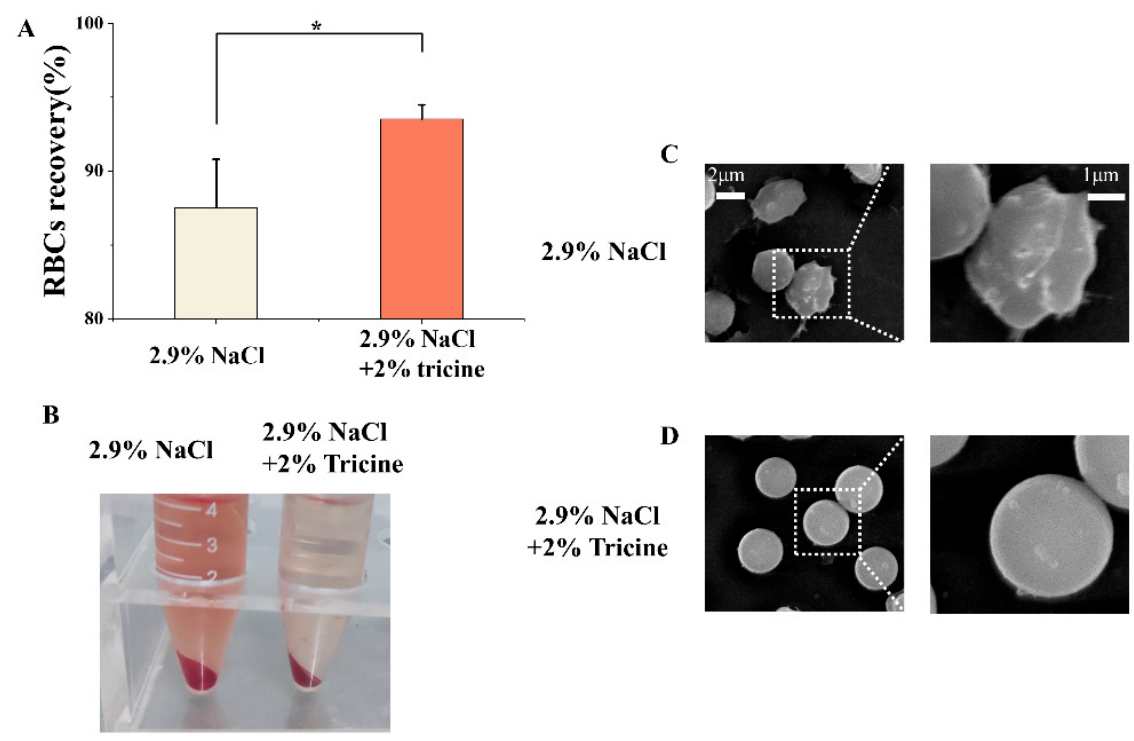
Figure 3. The osmotic regulation of tricine in a hypertonic environment. The recovery ( A ) and representative images ( B ) of RBCs incubated in 2.9% NaCl and 2.9% NaCl + 2% tricine solutions for 72 h. The representative SEM images of RBCs’ morphology after incubation in 2.9% NaCl ( C ) and 2.9% NaCl + 2% tricine ( D ) solutions for 72 h. Three replicates of each sample were tested and the data are shown as mean ± SD. * indicates p < 0.05.